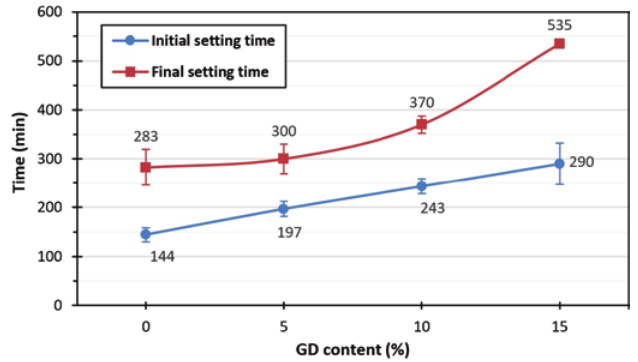
Variation of setting time of cement pastes as a function of the added GD content, using CP V-ARI